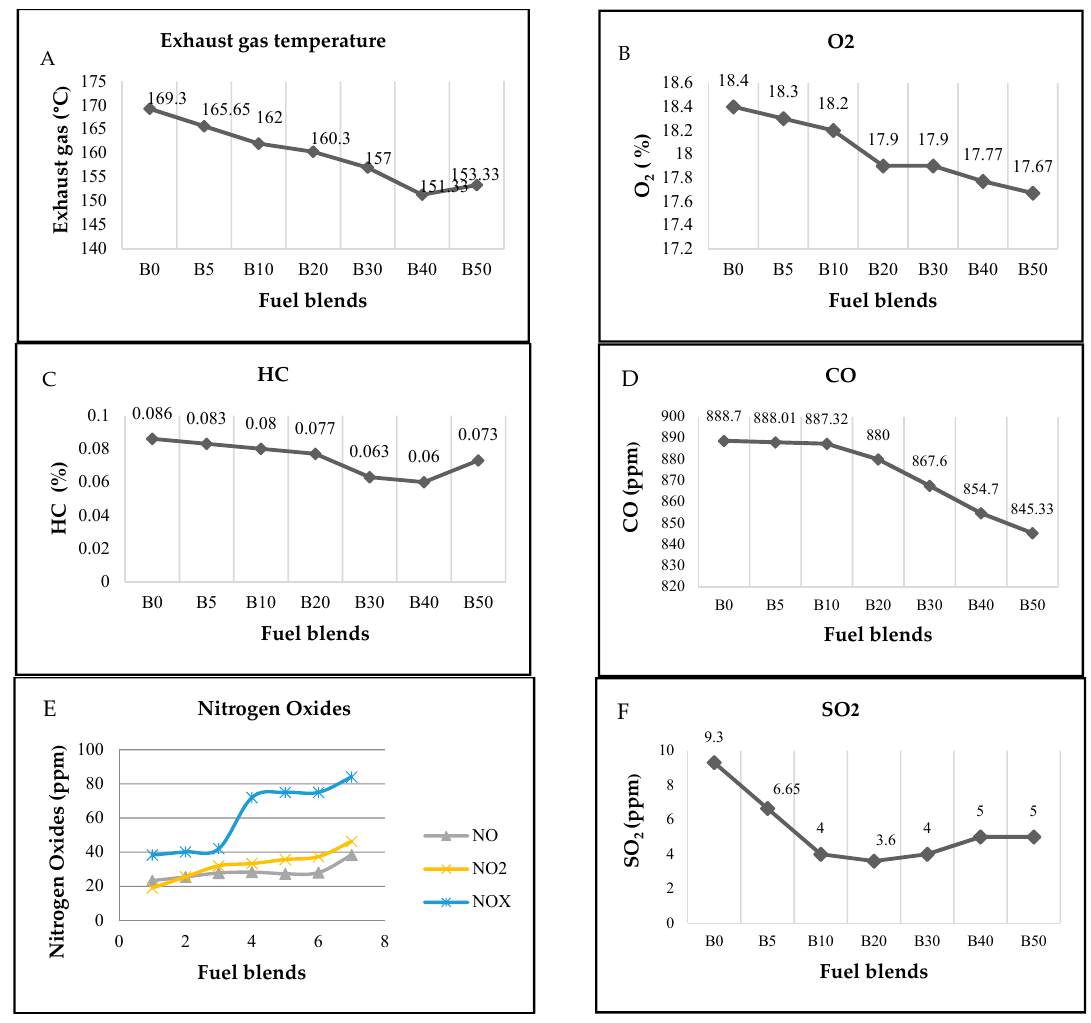
Figure 7. Experimental results with the monocylindrical engine.